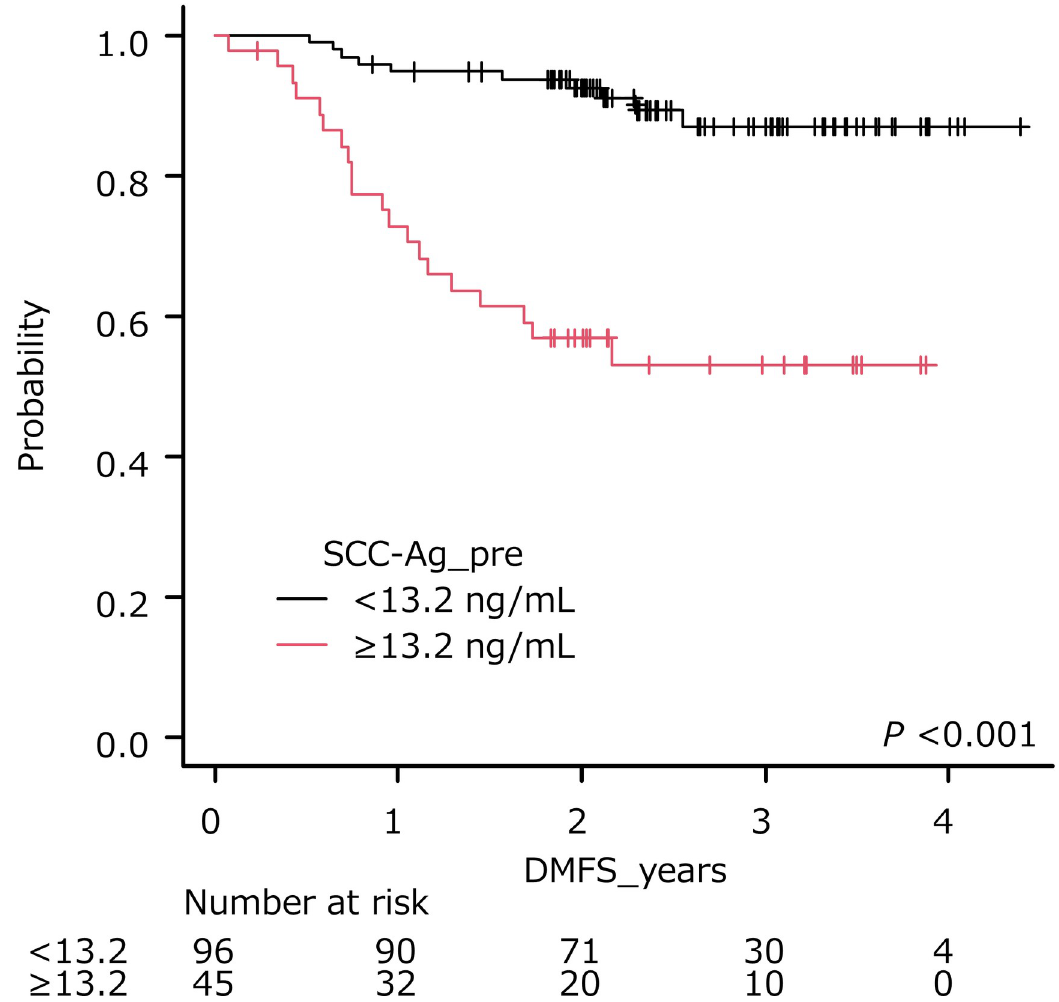
Fig 5. Distant metastasis-free survival of patients stratified by pretreatment SCC-Ag levels. Higher levels of pretreatment SCC-Ag ( � 13.2 ng/ml) were significantly associated with poorer outcome ( P < 0.001).